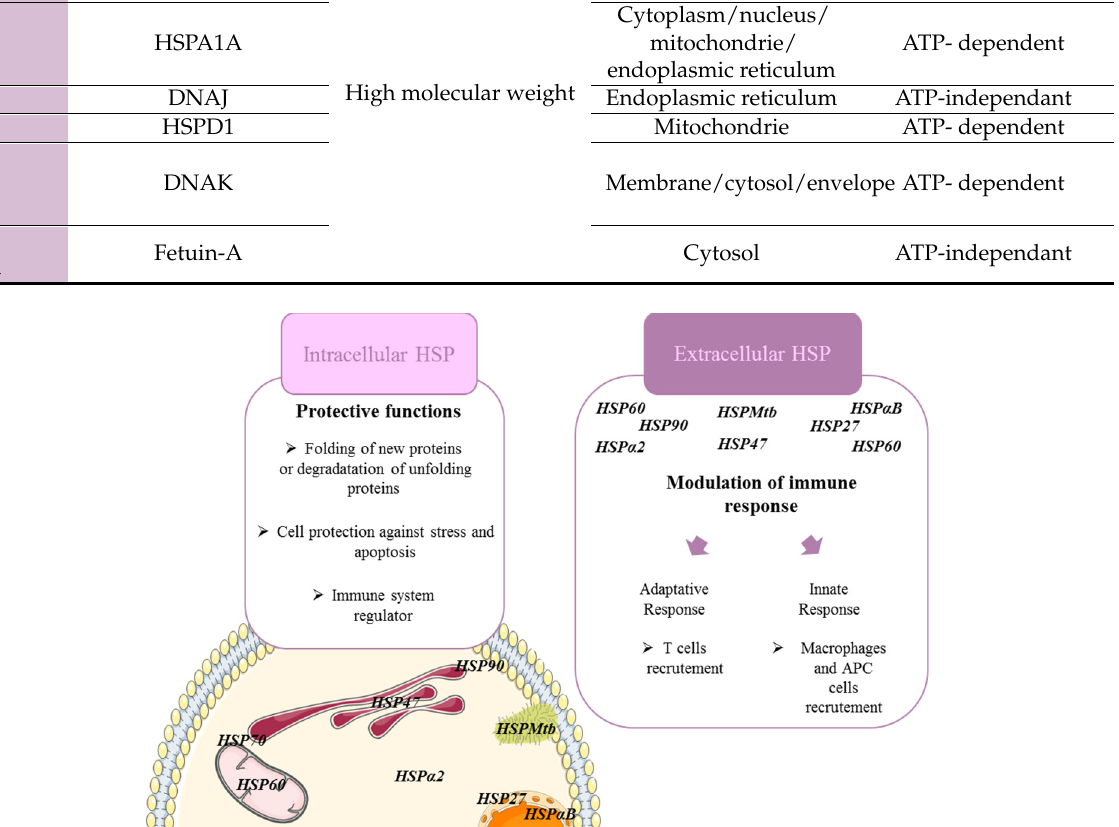
Figure 1. Schematic representation of HSPs’ biological functions. All HSPs mentioned are found in both intracellular and extracellular compartments. Table 1. HSP nomenclature and localization.